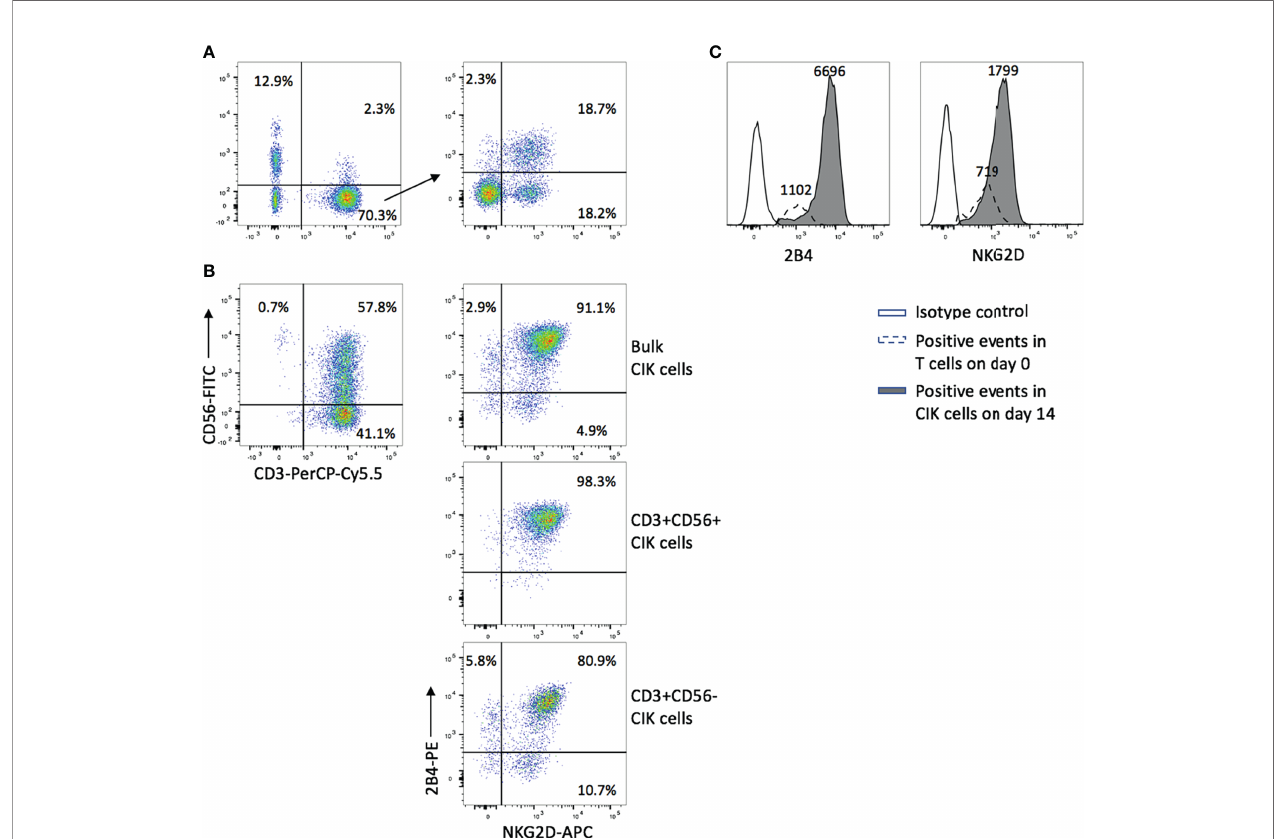
FIGURE 1 | NKG2D and 2B4 expression levels elevate over time in CIK culture. CIK cells were generated by culturing fresh PBMCs in the presence of IFN- g , anti- CD3 antibody, IL-1 b , and IL-2 for 14 days. NKG2D and 2B4 expression on T cells in freshly isolated PBMCs on day 0 (A) and CIK cells on day 14 (B) were measured by fl ow cytometry after staining with anti-CD3-PerCP-Cy5.5, anti-CD56-FITC, anti-NKG2D-APC, and anti-2B4-PE antibodies. (A) Dot plots show the phenotype of freshly isolated lymphocytes (left) and the expression of NKG2D (36.9%) and 2B4 (21.0%) within the CD3+CD56 − T-cell population (right). (B) Dot plots show the phenotype of mature CIK cells (top left), and the elevated expression of NKG2D and 2B4 on bulk CIK cells (top right), CD3+CD56+ subset (middle), and CD3+CD56 − subset (bottom). (C) The intensity of NKG2D and 2B4 on bulk CIK cells was increased over 14-day culture in comparison to the fresh T cells. Number indicates the median fl uorescence intensity. The fi gure shows data from one representative from four